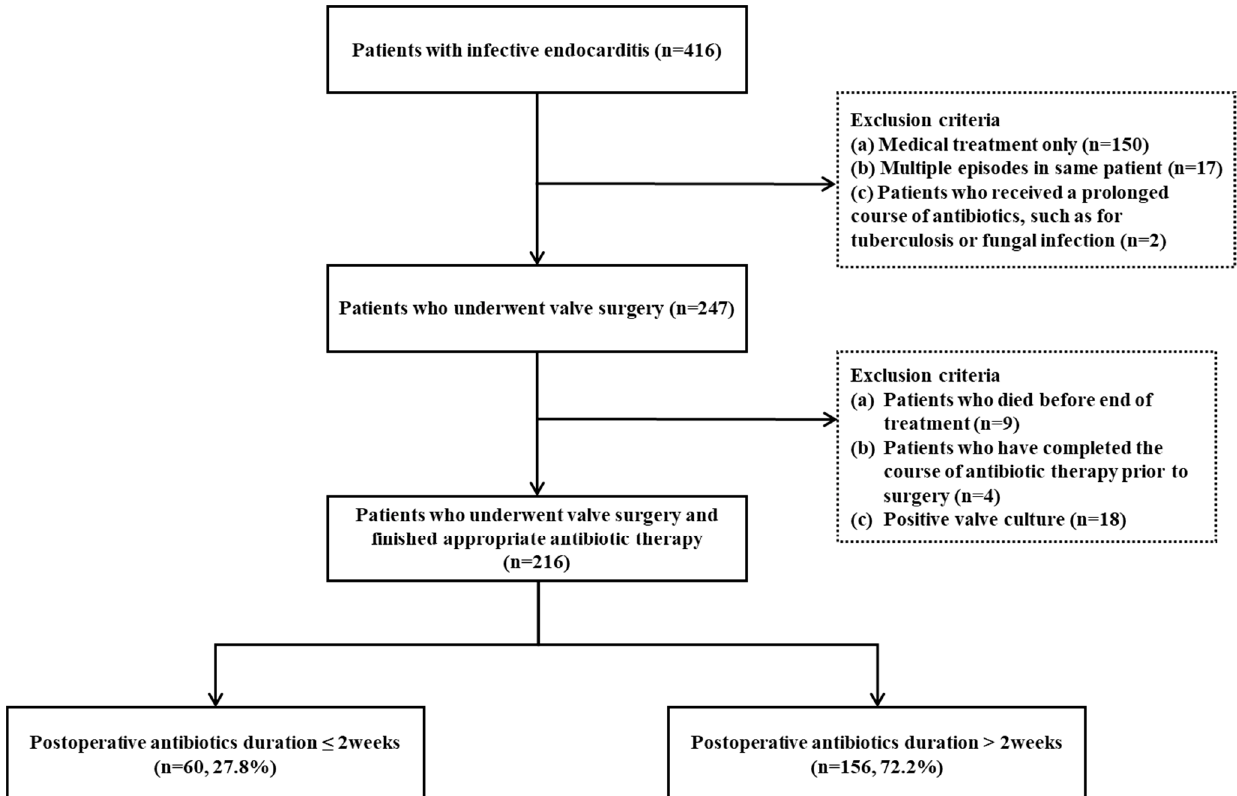
Figure 1. Flow chart of study patients with infective endocarditis. The median age of the patients was 53 (interquartile range [IQR], 38–62) years, and 67.1% of the patients were male (Table 1). Multiple-valve involvement was observed in 19.9% of IE patients. A previous history of IE was reported in eight patients (3.7%), and a prosthetic valve was reported in 25 patients (11.6%). The median Charlson Comorbidity Index was 1 (IQR, 0–3), and the median European System for Cardiac Operative Risk Evaluation (EuroSCORE) value was 2.04 (IQR, 1.53–2.83). Streptococcus species